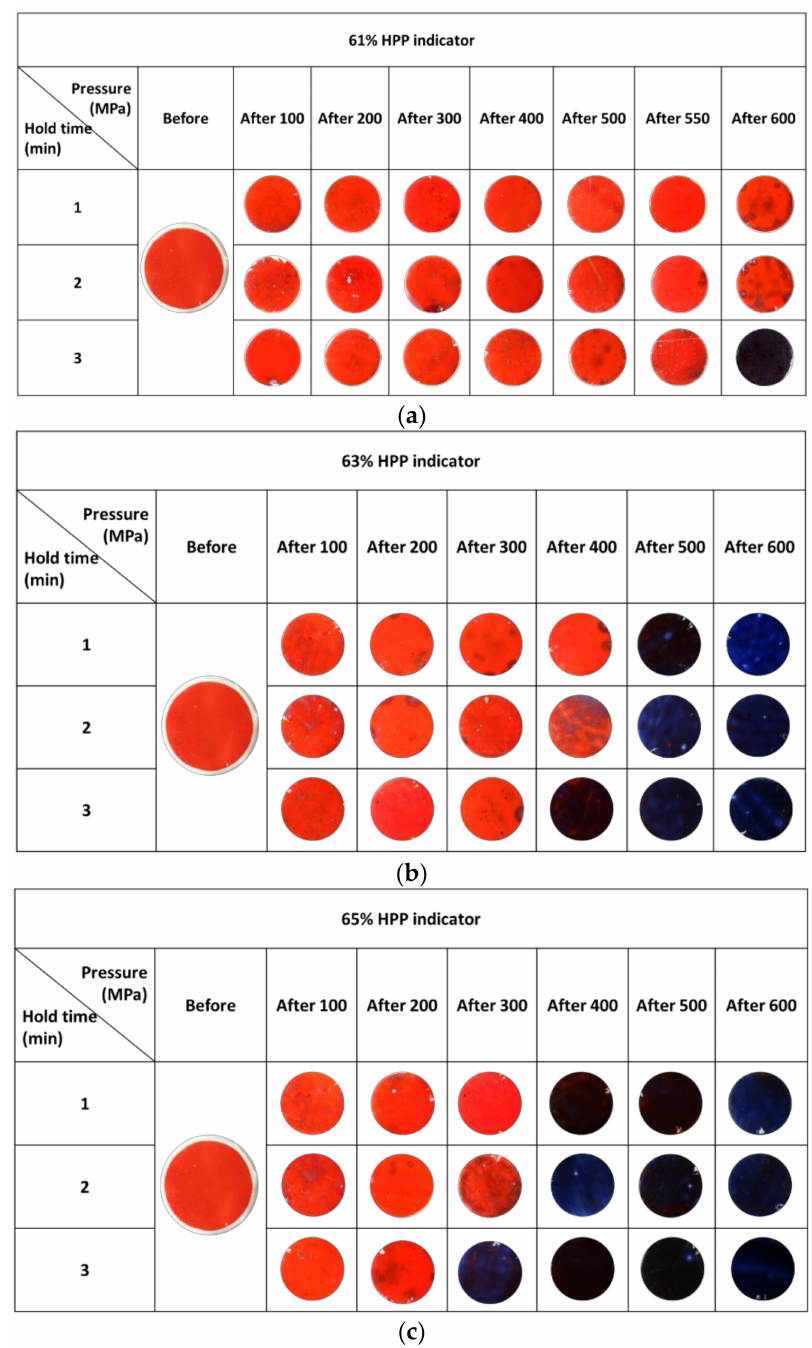
Figure 5. Digital images of three different HPP indicators before and after exposure to a series of different HPP pressures, ranging from 100–600 MPa, and times, ranging from 1–3 min. The three types of HPP indicators tested were all constructed as described in the experiment, but with the silica gel loaded with ( a ) 61, ( b ) 63, and ( c ) 65 wt% acidified water, respectively. The initial and